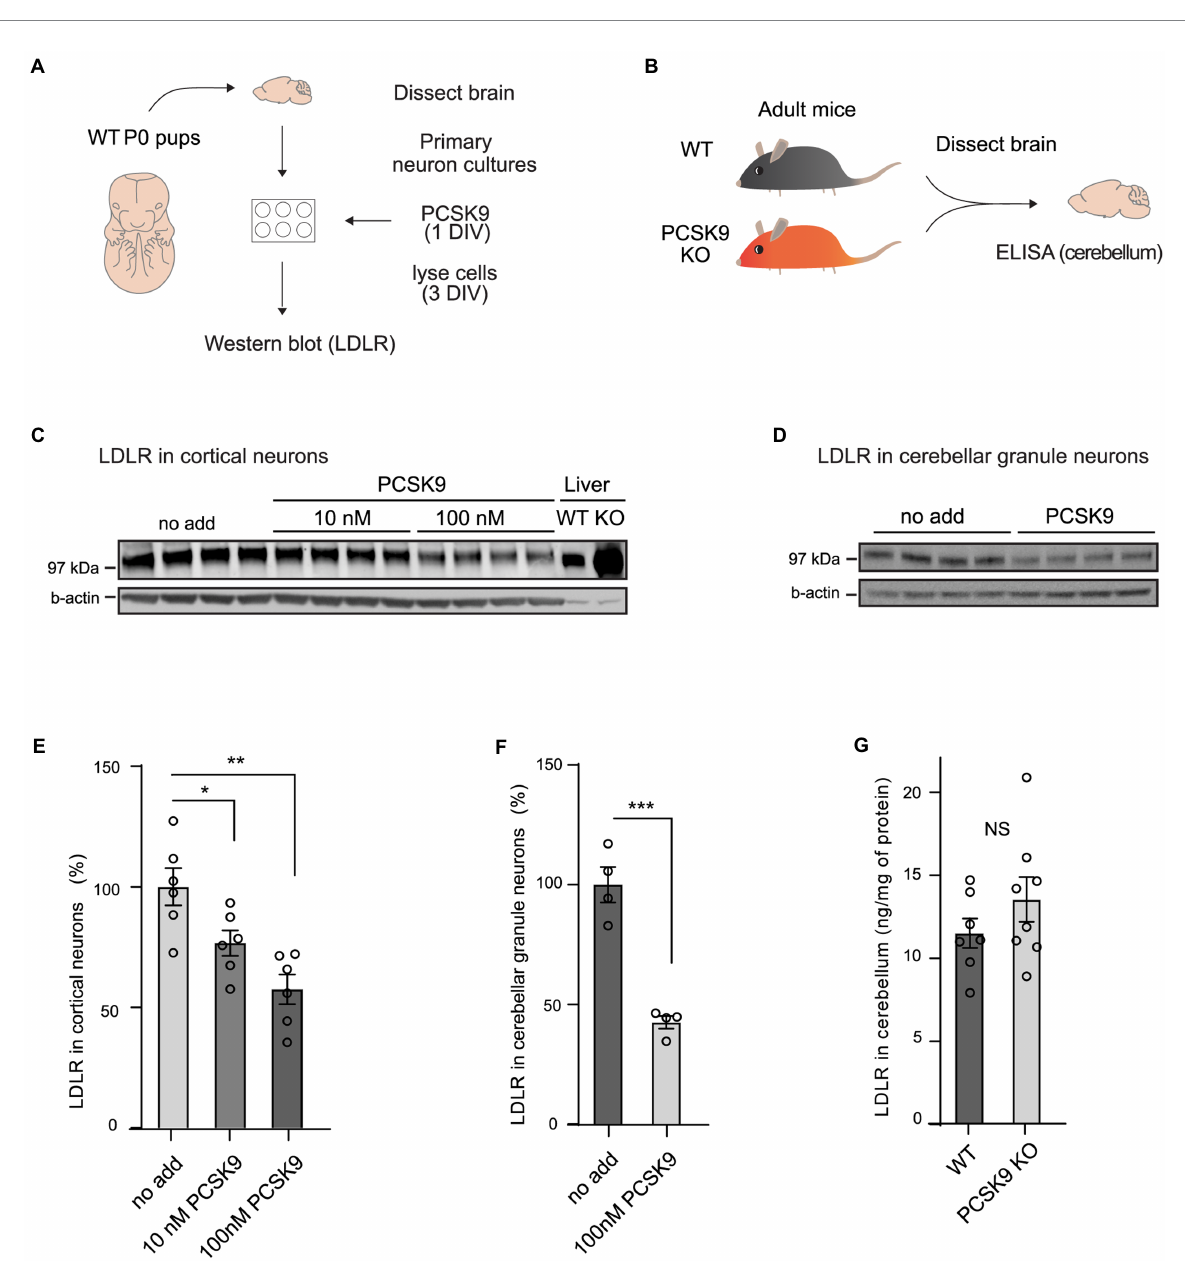
FIGURE 1 PCSK9 targets LDLR in neuronal cell cultures but not in adult cerebellum. (A) Schematic representation of the experiment with PCSK9 treatment on primary neuronal cultures. (B) Schematic representation of the assessment of the LDLR levels in the PCSK9 KO mouse cerebellum using ELISA. Representative Western blots of LDLR receptor in cortical (C) and cerebellar granule neurons (D) . Primary cultures were treated with 10 nM or 100 nM concentration of PCSK9 at 1 day in vitro (DIV) and lysed at 3 DIV. Liver samples of WT and PCSK9 KO mice were added as control (C) . Densitometric quantification of LDLR normalized to β -actin in cortical ( n = 6; E ), and cerebellar granule neurons ( n = 4; F ). ELISA of LDLR in cerebellum ( n = 7 WT, 8 KO) of adult mice (3- to 12-month-old; G ). Data are represented as mean ± SEM. Statistical significance was evaluated using a two-tailed Student’s t-test, alpha = 0.05. Asterisks indicate significantly different values (NS p > 0.05; * p ≤ 0.05; ** p ≤ 0.01; *** p ≤